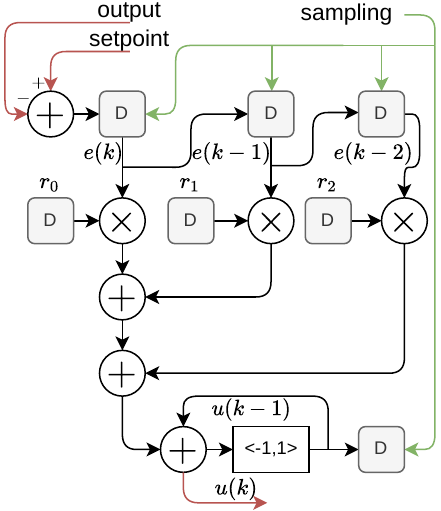
Figure 5. Current PID design implemented in the Matrix of Controllers.